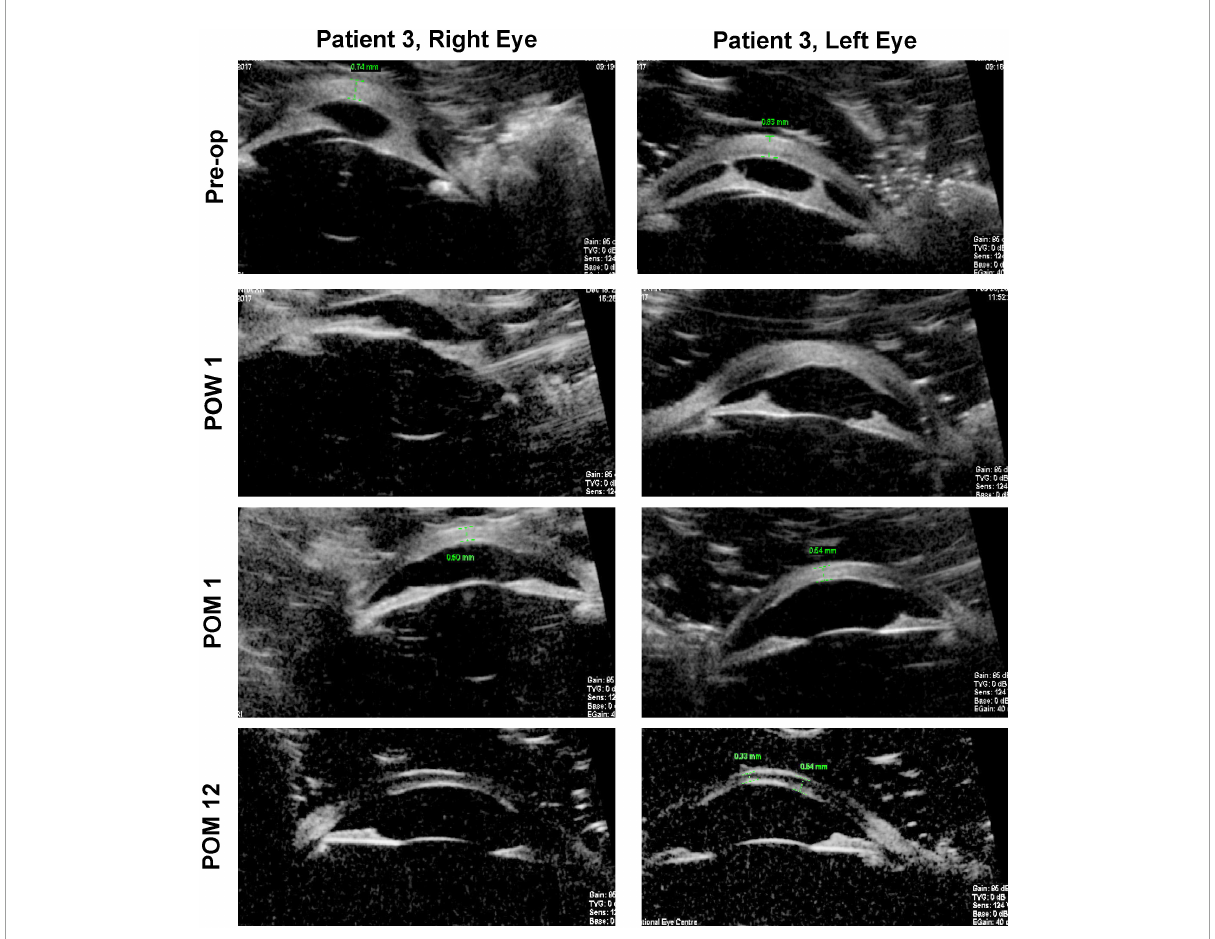
FIGURE3 Ultrasound biomicroscopy (UBM) images for both eyes of patient 3. Pre-operatively, thick paracentral bands of iridocorneal adhesions with shallow anterior chambers may be seen in both eyes. Serial post-operative UBM images demonstrate that these bands have been lysed, with normalization of anterior chamber depths. Pre-op, pre-operative; POW, post-operative week; POM, post-operative